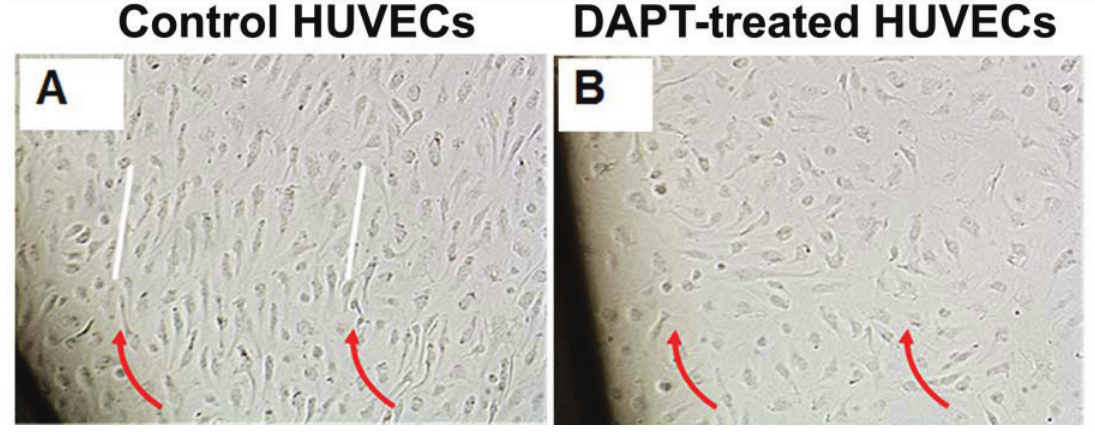
Figure 7. NOTCH loss of function abolishes cellular alignment in HUVECs in response to OSS. ( A ) Exposure of HUVECs to OSS resulted in a marked alignment of HUVECs (white lines) parallel to the direction of fluidic flow (red arrows) when treated with vehicle control; ( B ) HUVEC response to OSS was abolished in the presence of DAPT. Magnification